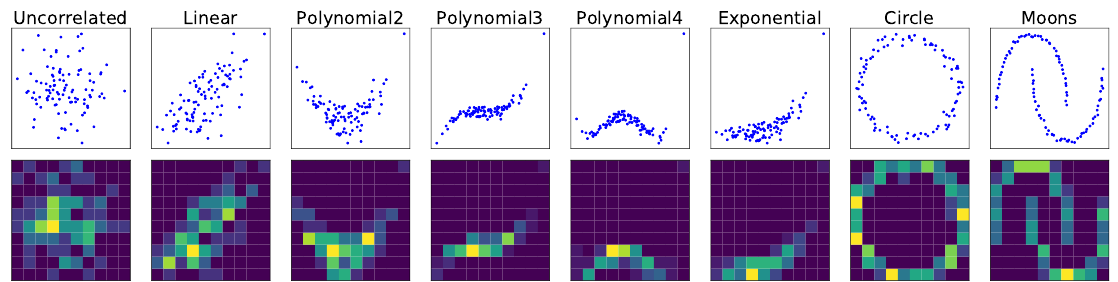
Figure 3. Examples of the synthetic datasets used to classify the types of dependency. Top: Scatter plots of the synthetic feature pairs. Bottom: 2D histograms of the synthetic feature